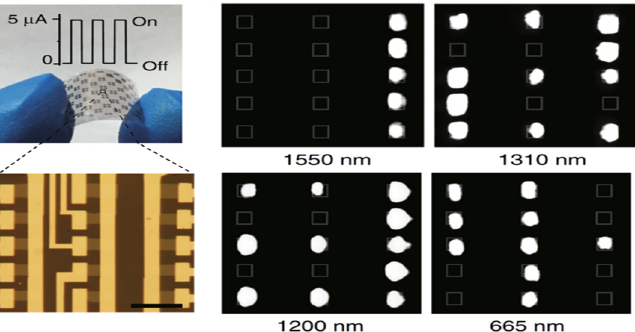
Figure 15. Flexible 2D arrays of Bi 2 O 2 Se photodetectors. Images of 2D Bi 2 O 2 Se photodetectors and arrays on mica (top left). The inset shows the photoresponse of one of the photodetectors when the substrate is bent with a deformation of up to 1%. The current rises at 1200 nm IR illumination with a power of about 100 μ W. Photocurrent images with shapes 1, 2, 3, and 4 were obtained under illumination with light at 1550 nm, 1310 nm, 1200 nm, and 665 nm, respectively [45].